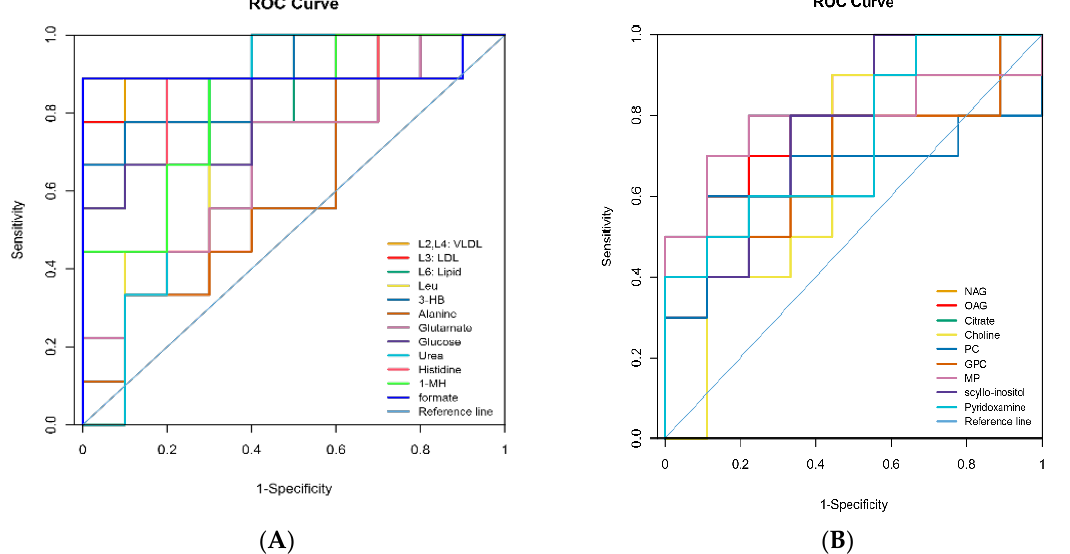
Figure 5. ROC (receiver operating characteristics) analysis of biomarkers from the milk ( A ) and plasma ( B ) for cows from the HS (heat stress) and TN (thermoneutral)